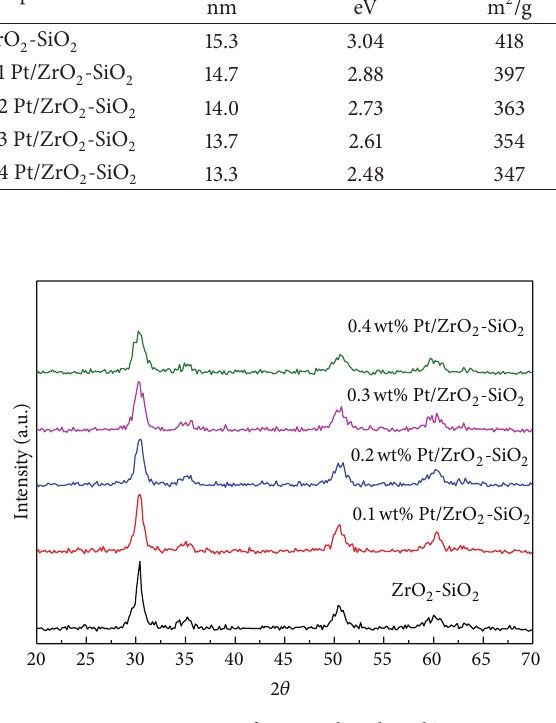
Figure 2: XRD patterns of pure and Pt doped ZrO 2 -SiO 2